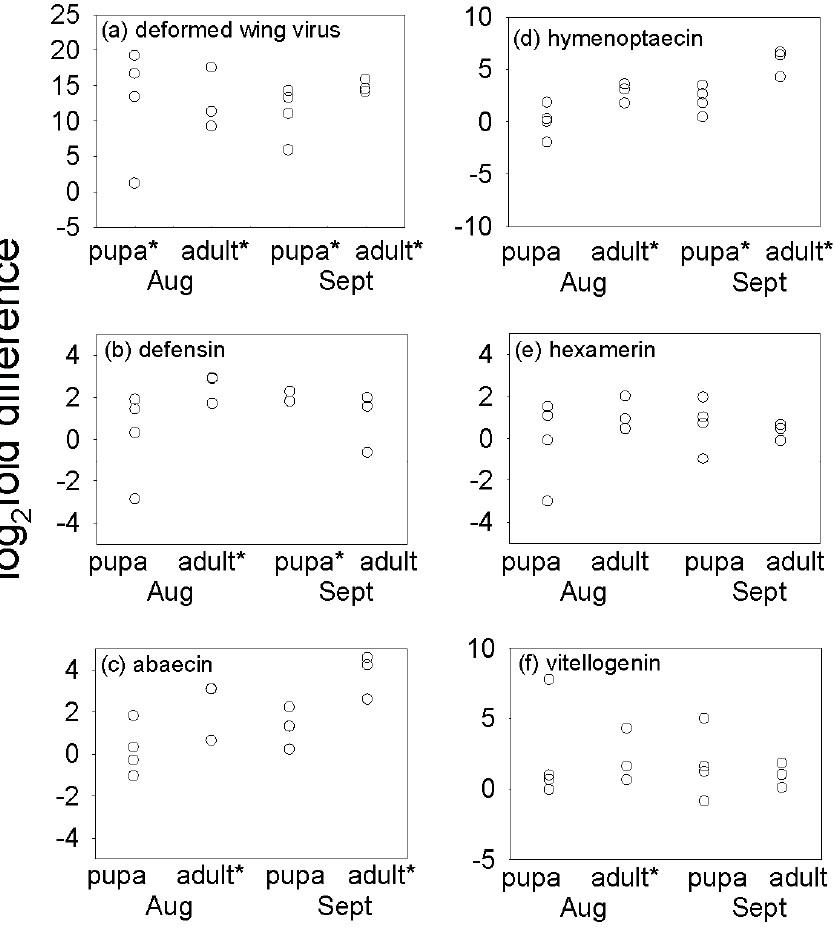
Figure 2. Impact of Varroa infestation of pupae and newly-emerged adults on ( a ) the titer of deformed wing virus; expression of anti-microbial peptides: defensin1 ( b ), abaecin ( c ) and hymenoptaecin ( d ); and expression of storage proteins: hexamerin 70b ( e ) and vitellogenin ( f ). Mean values of log ( Varroa -infested/uninfested)of three replicate samples from each colony are 2 shown, and values significantly different from zero (after Bonferroni correction for four tests) are indicated *. Full statistical analysis is shown in Supplementary Table